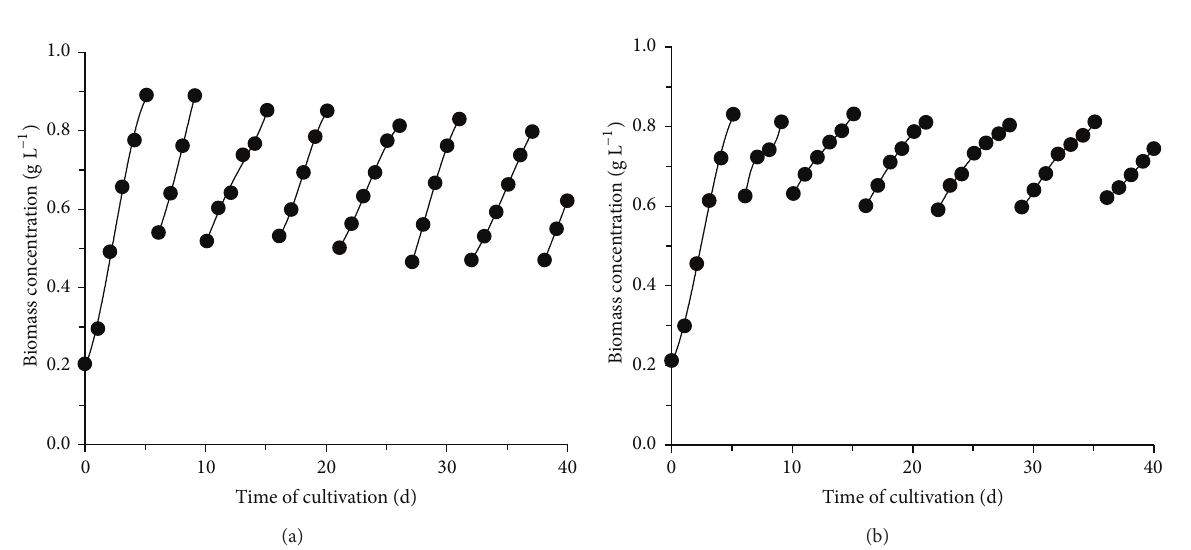
Figure1:Cellularconcentrationofsemicontinuouscultivationasafunctionoftimefor(a)blendconcentrationof0.80 g L −1 ,mediumrenewal rate of 50%, and sodium bicarbonate concentration of 1.60g L −1 (experiment 12) and (b) blend concentration of 0.80 gL −1 , medium renewal rate of 30%, and sodium bicarbonate concentration of 0.40 g L −1 (experiment 9).